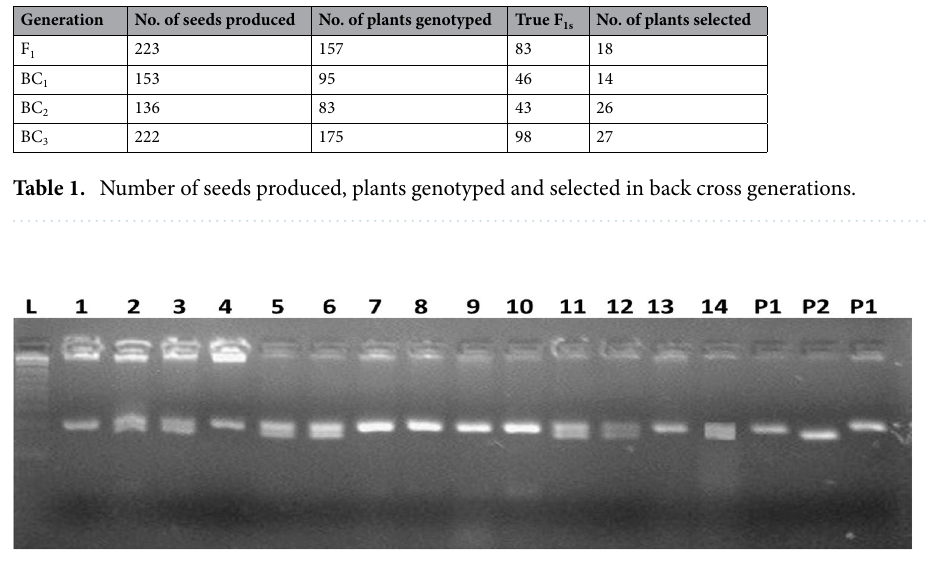
Figure 1. Gel picture showing RM336 maker segregation in BC 3 F 2 generation. L—Ladder, P1—Susceptible (BRRI dhan71) and P2—Resistant (Matatag 1).